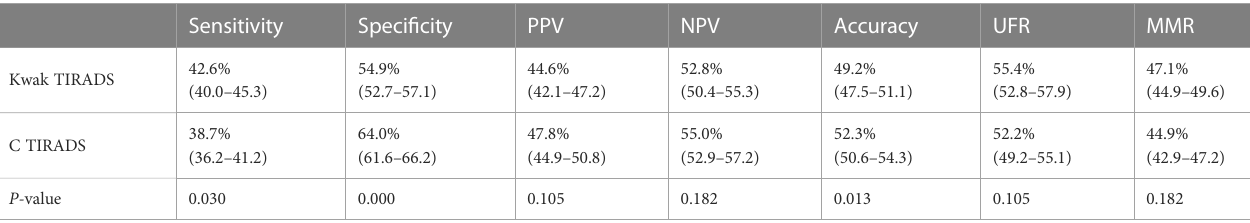
TABLE 4 Diagnostic performances of biopsy in the Kwak and C TIRADS.